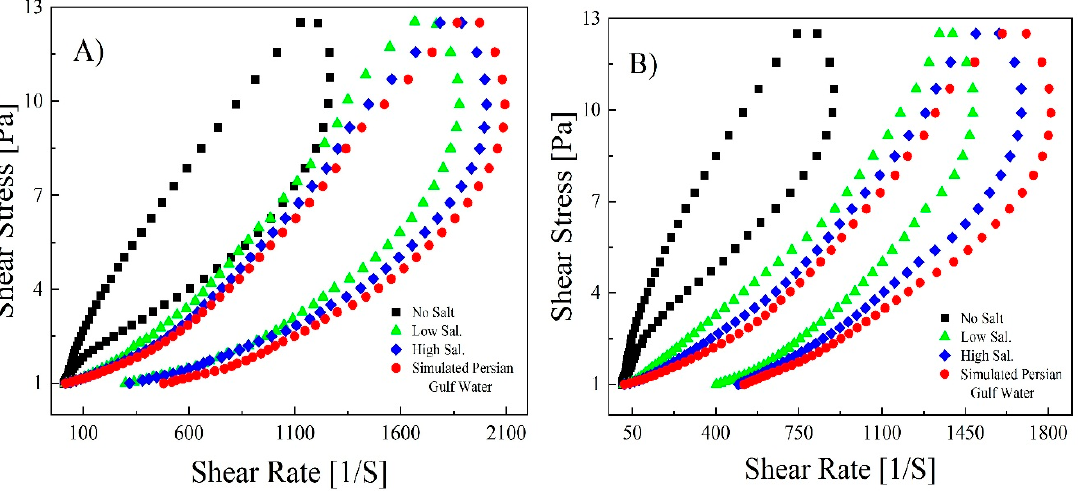
Figure 7. Thixotropic curves of B192 polymer solution at a concentration of 1000 ppm ( A ) and 1500 ppm ( B ) at different salt concentrations.